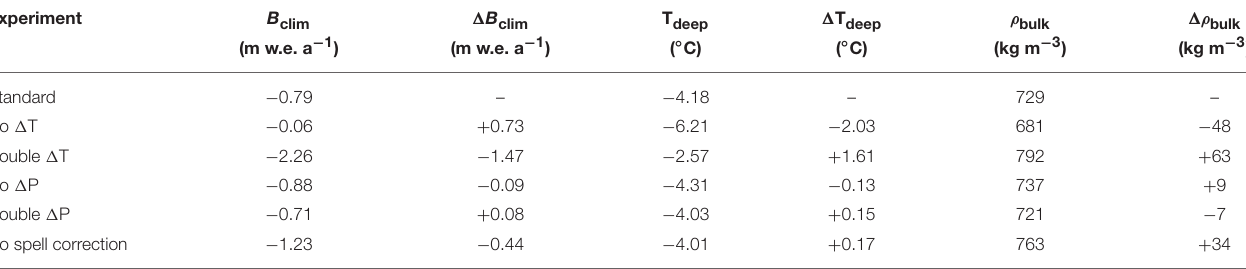
TABLE 1 | Sensitivity of the 2014–2104 mean climatic mass balance ( B clim ), 15-m deep temperature (T deep ) and 0–10 m bulk density ( ρ bulk ) to different temperature and precipitation scenarios. Experiment